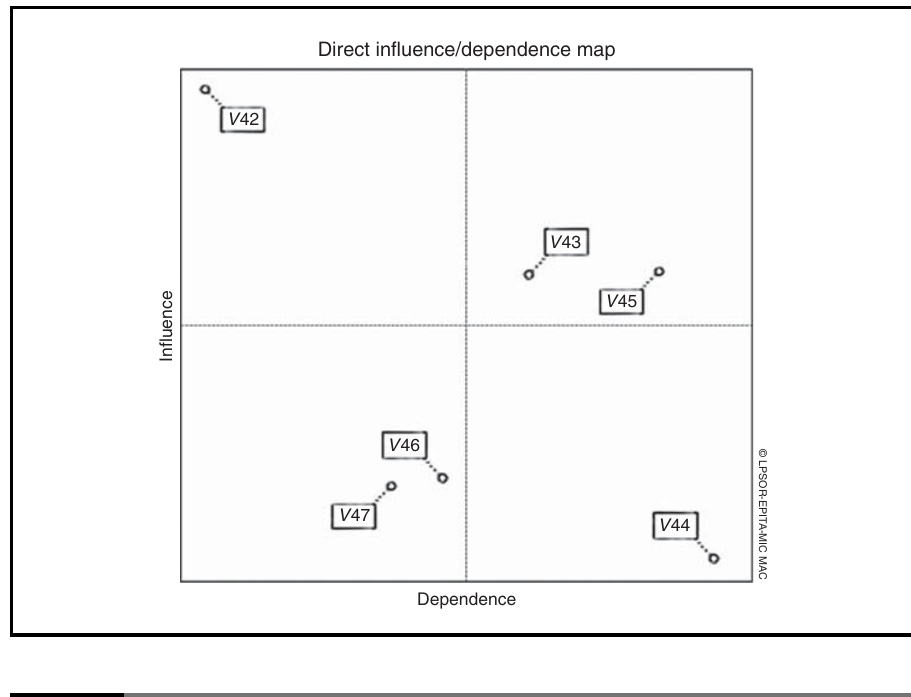
Figure 11 Direct environmental positive influence and dependence